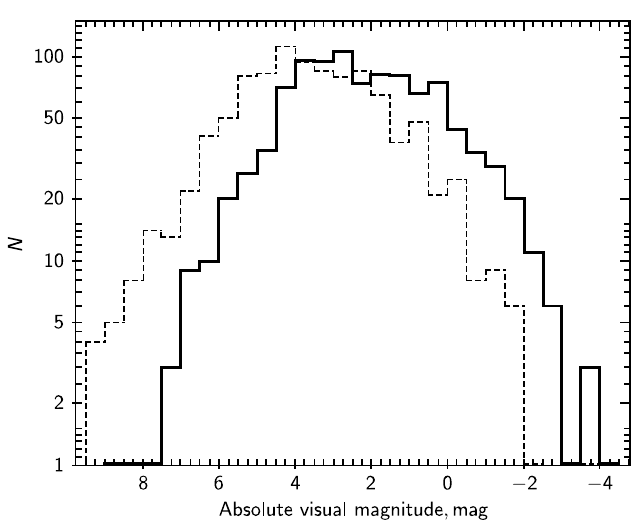
Fig. 8. Distributions of the absolute magnitudes for the primaries (the solid line) and secondaries (the dotted line) in the restricted sample of 998 visual binaries. The dataset is still not free of selection effects and cannot be viewed as representative of the initial or present-day distribution of binary